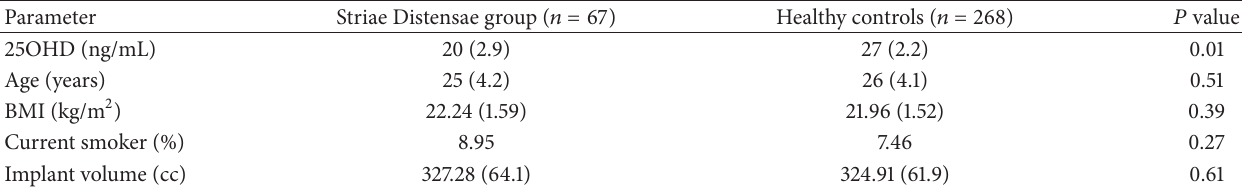
Table 1: Comparison of cases in Striae Distensae and non-Striae Distensae groups.